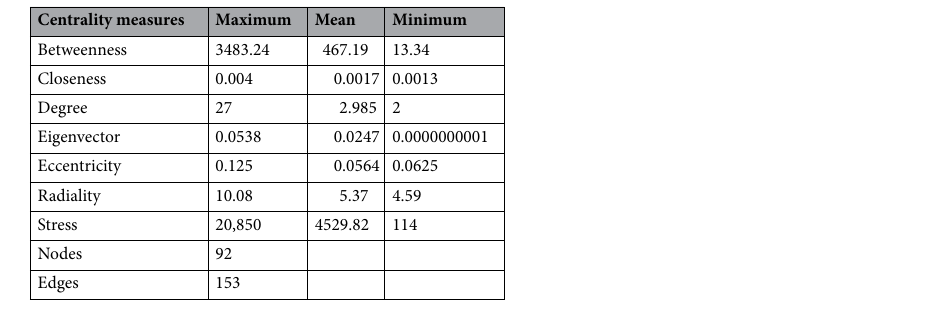
Table 1. The nodes and edges of influential protein